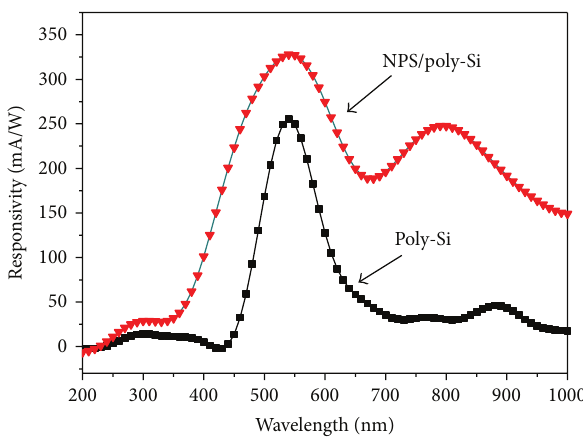
Figure 4: Photoresponse spectra of the NPS/poly-Si cell and the poly-Si